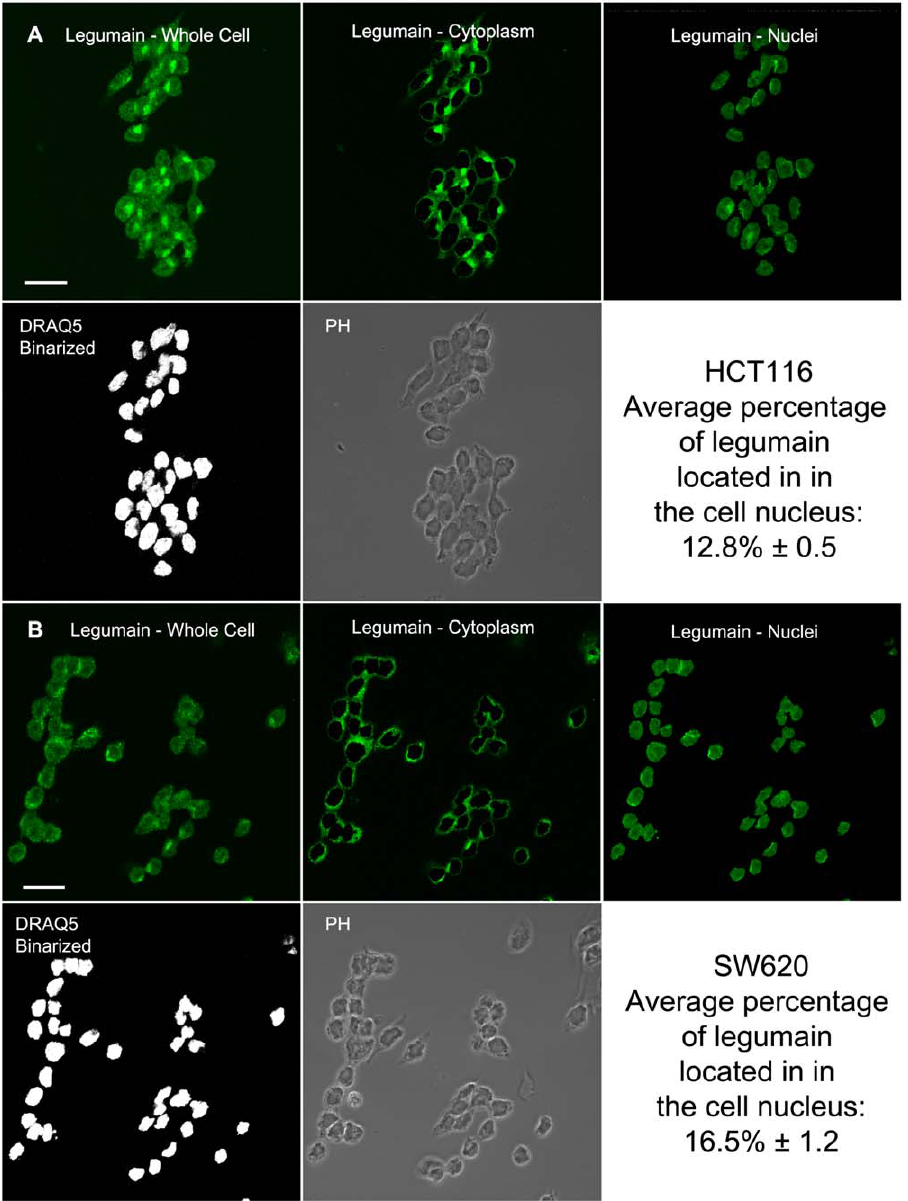
Figure 5. Percentage of expressed legumain located in the nucleus. (A and B) Representative pictures of HCT116 (A) and SW620 (B) cells by one optical slice from one of five independent z-stacks each containing 30–40 immunofluorescently labeled cells using legumain-specific antibodies (green), with DRAQ5 TM counter-stained nuclei (binarized; white). By means of a semi-automated procedure in Image J the captures of nuclei (binarized) was used as a mask to separate the nuclear (top right) from the cytoplasmic (top middle) signal components of the total (top left) signal representing expression of legumain. The total signal from legumain fluorescence in each optical slice was summarized from all five z-stacks enabling for the estimation of the expressed amount of legumain in the nuclear compartment. Statistical errors in the calculations are reported as standard error of the mean of the five independent z-stacks. Scale bar represents 20 m m.